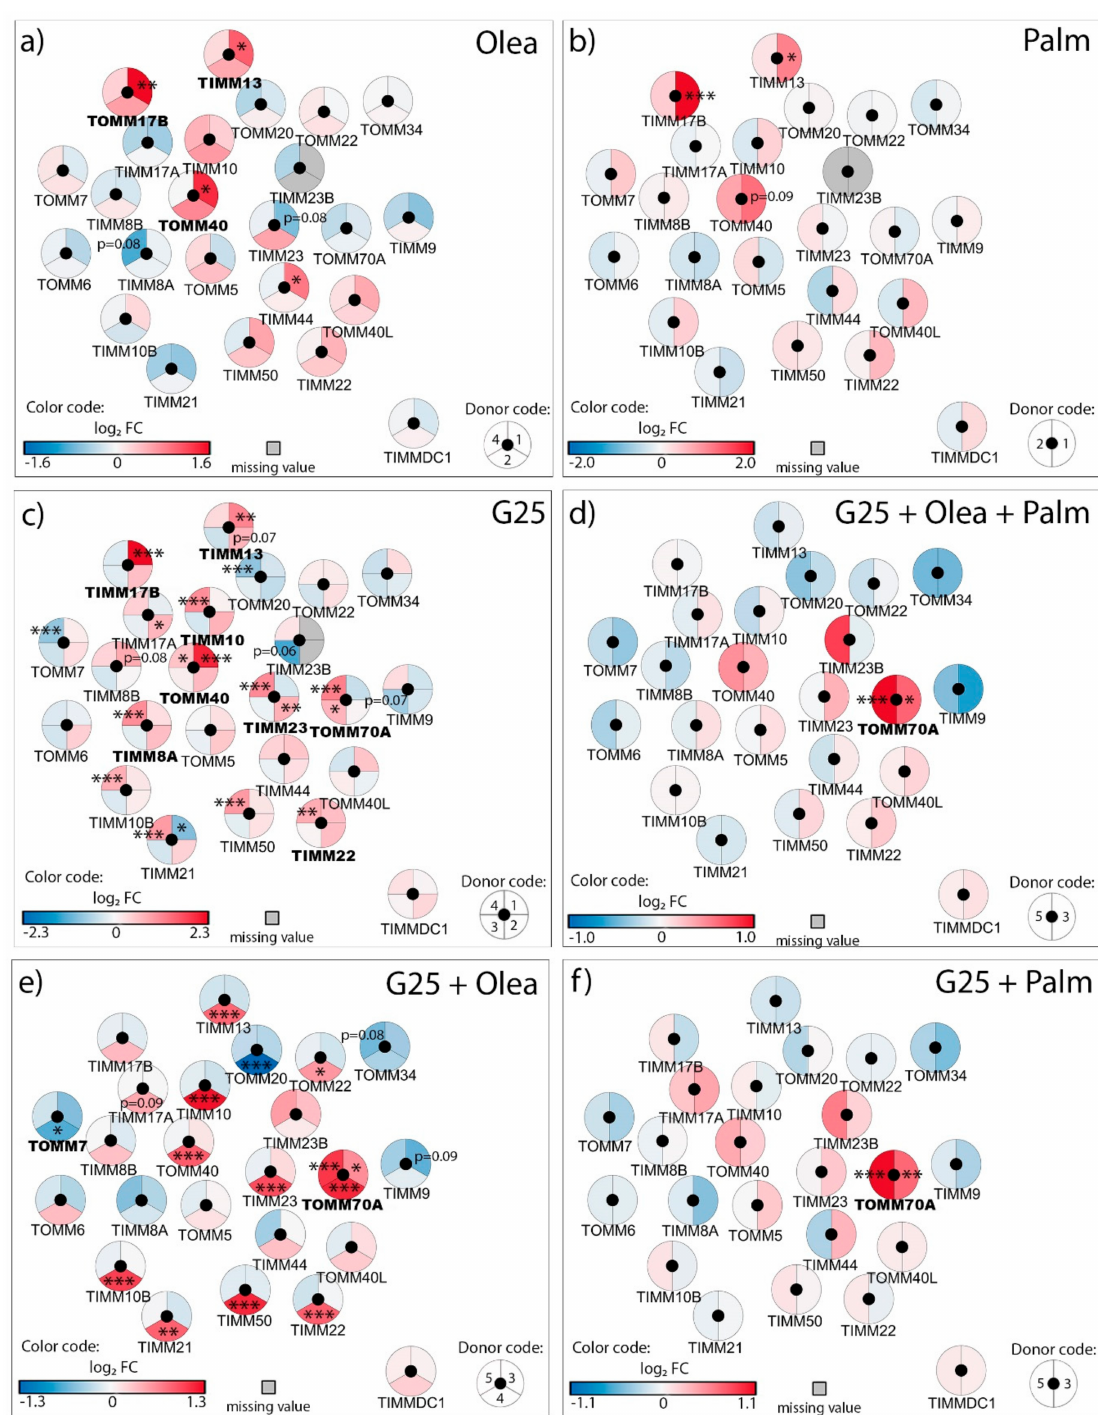
Figure 5. Effects of high 25 mM glucose (G25) and 0.4 mM oleate (Olea) or palmitate (Palm) on the transcriptional regulation of the outer and inner mitochondrial membrane translocases TOM / TIM. Human islets were exposed to ( a ) Olea at G5.5, ( b ) Palm at G5.5, ( c ) G25, ( d ) G25 + Olea + Palm, ( e ) G25 + Olea, and ( f ) G25 + Palm for 3 days before RNA-Seq analysis. E ff ects of culture conditions on transcript levels are compared to standard G5.5 medium and shown as upregulated (red), downregulated (blue), or unchanged (white). Missing values are represented in grey. Each disk is split into individual changes for the di ff erent donors. Color code reflects the transcriptional changes in log 2 fold changes (log 2 FC) for that particular gene in individual donors. * adjusted p < 0.05, ** adjusted p < 0.01, *** adjusted p < 0.001 between control 5.5 mM glucose and the specific culture